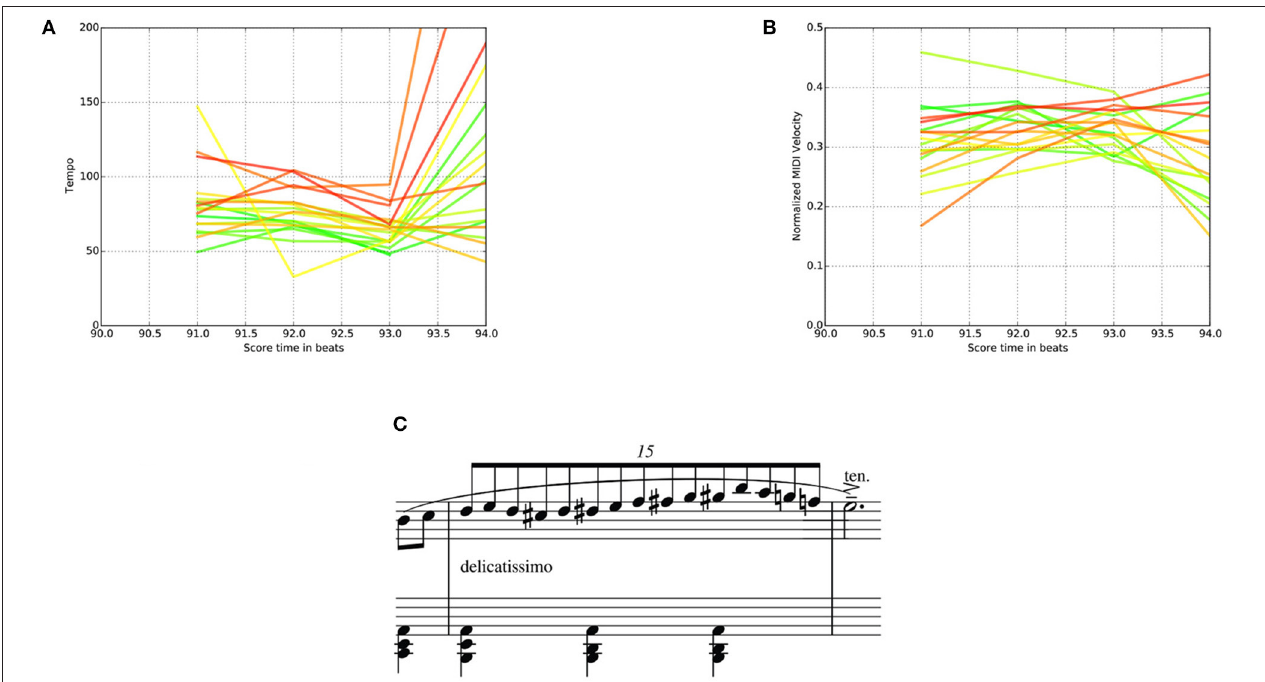
FIGURE 17 | Tempo-Loudness Evolution Graphs for expert player E-1, for both loudness and tempo (Top) of a short music fragment (beats 90–94) (Bottom). Time progression is shown through the color of the plots, which range from green (beginning of practice session) to red (end of practice session). (A) Tempo-Loudness Evolution Graph for tempo. (B) Tempo-Loudness Evolution Graph for loudness. (C) Corresponding score.